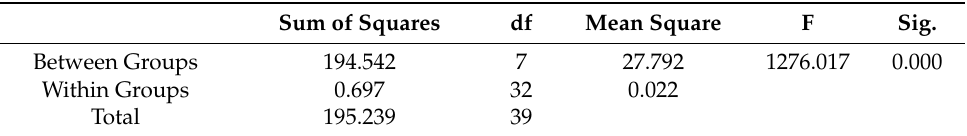
Table 10. ANOVA for Dataset I.